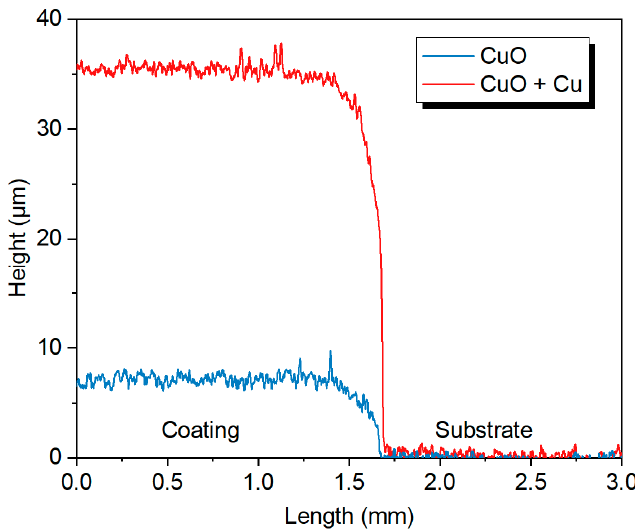
Figure 7. Surface profile of a thick Cu coating and of a CuO intermediate layer (measured sepa-